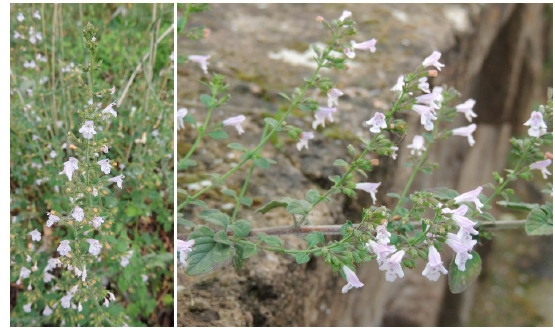
(photo: Mijat Božovi´c,